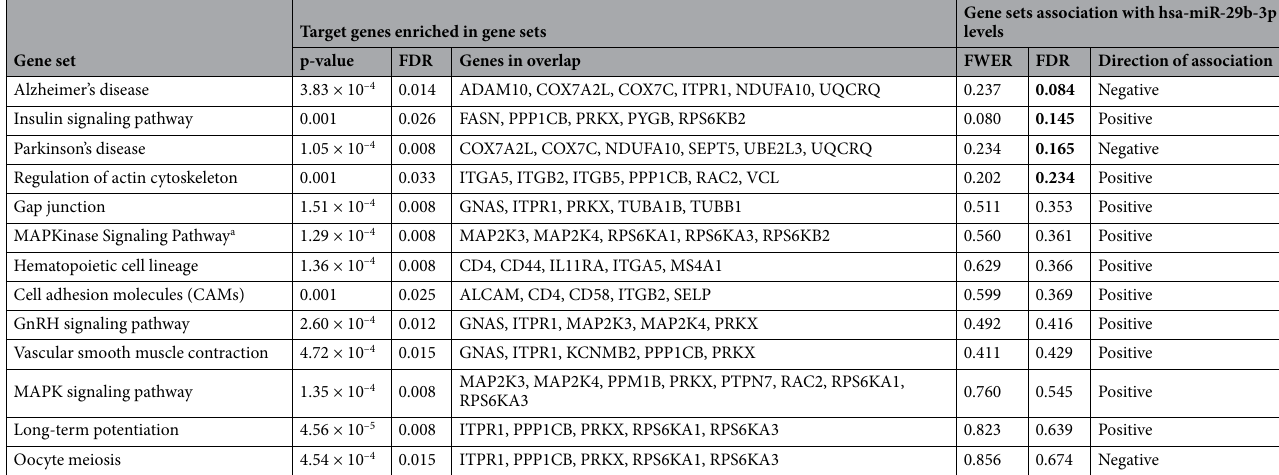
Table 1. Target-mRNA driven gene set enrichment analysis for hsa-miR-29b-3p levels. Thirteen gene sets were enriched with predicted and correlating (FDR < 0.25) targets of hsa-miR-29b-3p. When performing GSEA for these 13 gene sets and hsa-miR-29b-3p levels, four were associated (FDR < 0.25, in bold) with the expression of hsa-miR-29b-3p. This indicates a possible hsa-miR-29b-3p target mRNA driven regulation of these gene sets. The flow and results of transcriptomics and gene set analysis are presented in Supplementary Fig. S1 Notes All gene sets except MAPKinase Signaling Pathway (BIOCARTA a ) are from KEGG collection. Both gene-expression data and hsa-miR-29b-3p levels were available from 559 study subjects. GSEA gene set enrichment analysis; FDR False discovery rate.